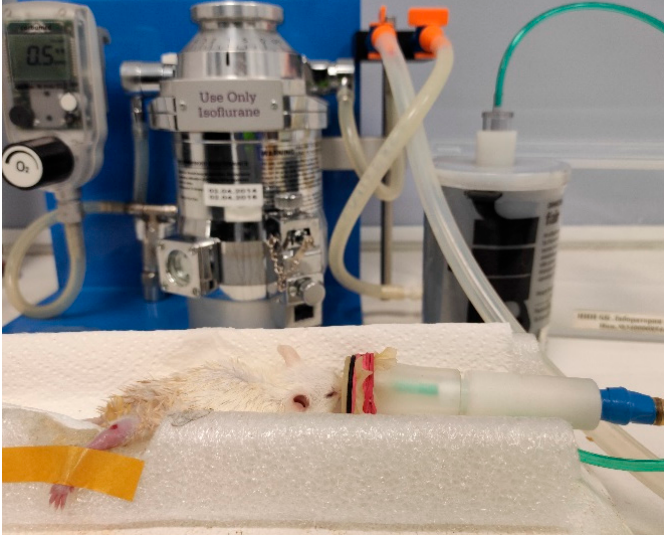
Figure 1. A mouse anesthetized by isoflurane, using the Ugo Basile gas anesthesia system